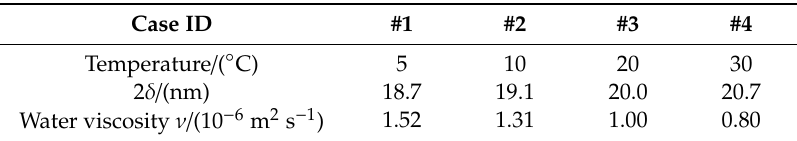
Table 1. Parameters in each case.